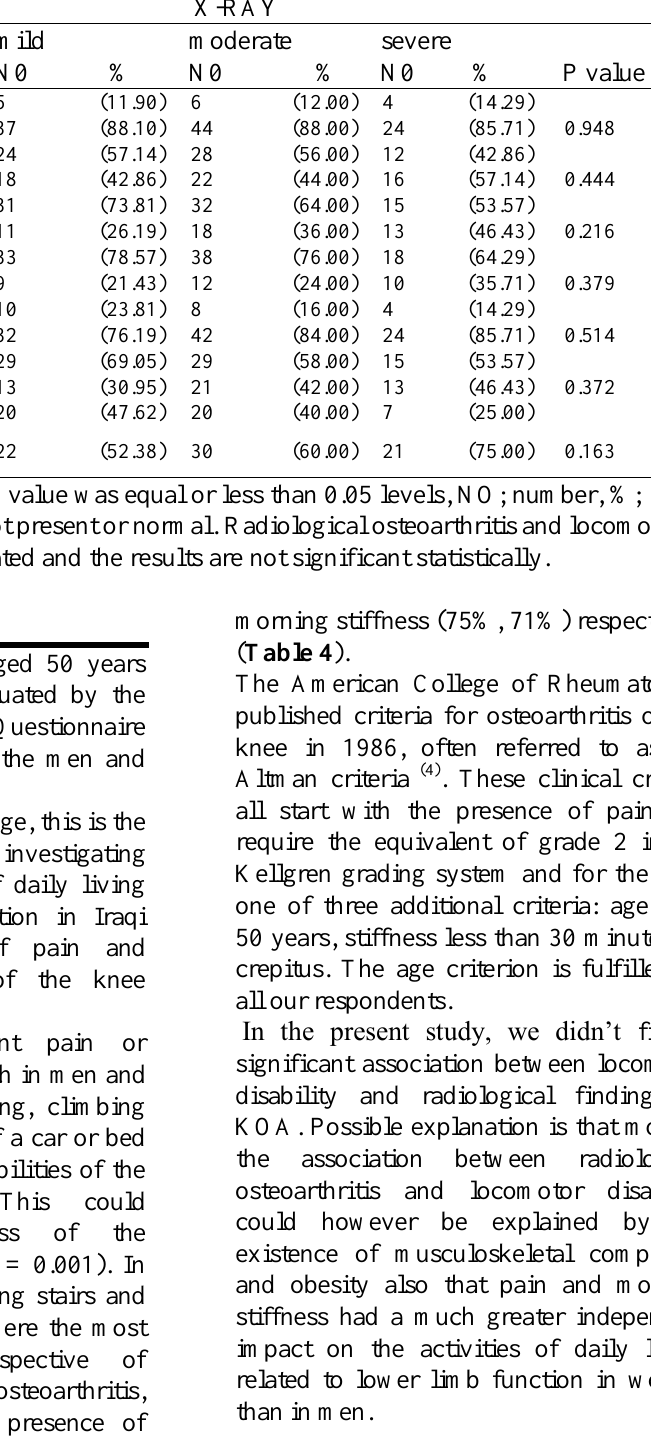
Table 5: Distribution of radiological findings with disability in the six separate functions, which constitute the locomotor disability index, within knee osteoarthritis patients.